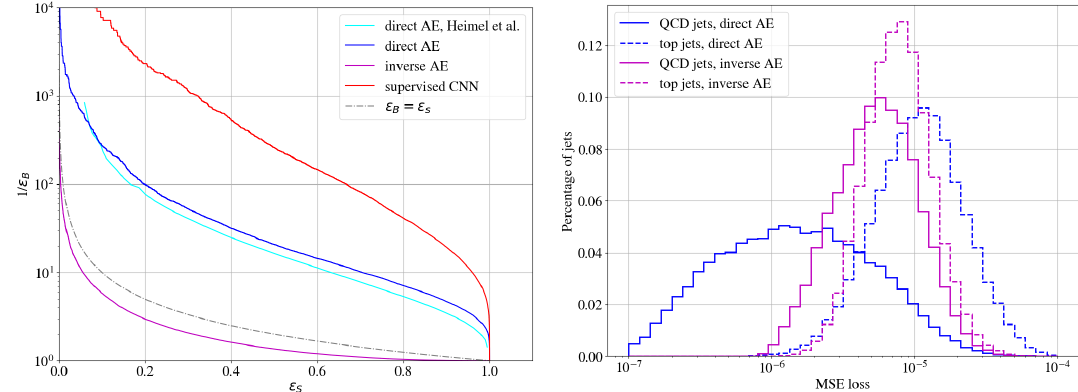
Figure 7 . Left: ROC curve of our direct (dark blue) and inverse (purple) tagger. For comparison we also show the performance of a supervised CNN tagger (red), the results of ref. [30] for the direct tagger, and a random tagger (grey dashed). Right: loss distribution for QCD (solid) and top (dashed) images for the direct (blue) and inverse (purple)